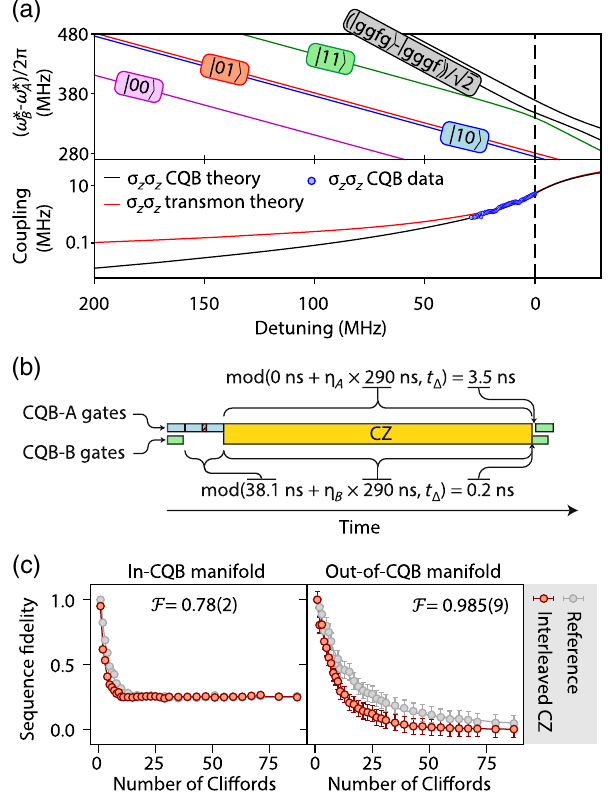
FIG. 4. Two-CQB gates. (a) Controlled- Z (CZ) gate between CQB-A and CQB-B (upper panel), performed by adiabatically ramping the CQB diabatic frequencies (at the transmon energy and ω (cid:2) [31], to the avoided level crossing degeneracies) ω (cid:2) B A between j 11 i and the hybridized second excited states ffiffiffi p 2 ðj g 1 ; g 2 ; f 3 ; g 4 i − j g 1 ; g 2 ; g 3 ; f 4 iÞ =